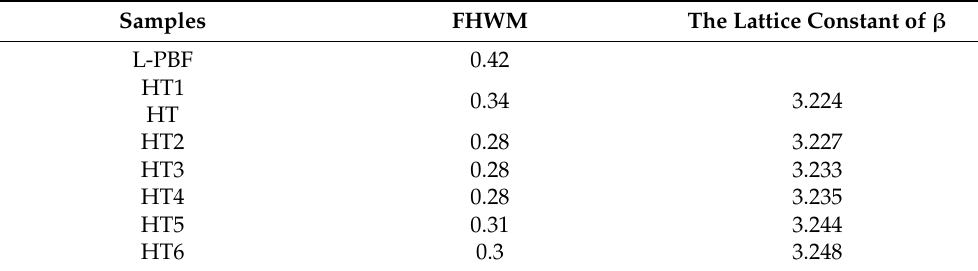
Table 3. FHWM at different annealing temperatures (2θ ~40.5 °C ) and the lattice constant of the β phase at various heat treatments.